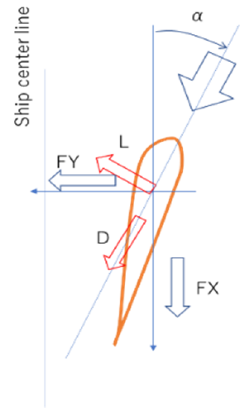
Figure 6. Rudder forces originated from lift and drag.